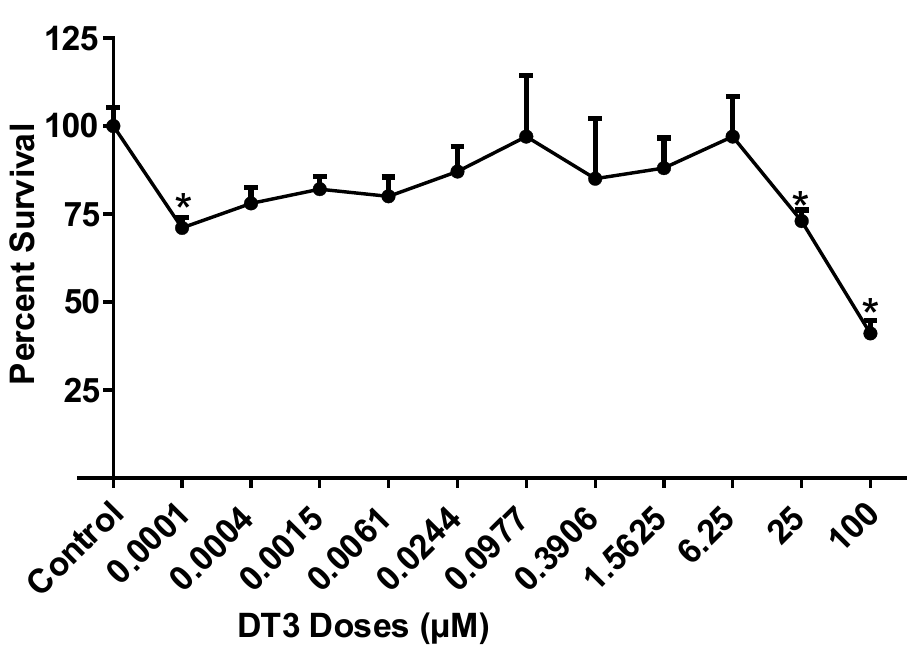
Figure 1. Delta-tocotrienol does not reduce cell viability up to 25 µM. Delta tocotrienol ( DT3) were tested at doses ranging from 0.001–100 µM in 3T3-L1 adipocytes. DT3 at doses below 25 µM except 0.0001 µM had no difference in cell viability compared to control. n = 3 , * p < 0.05.